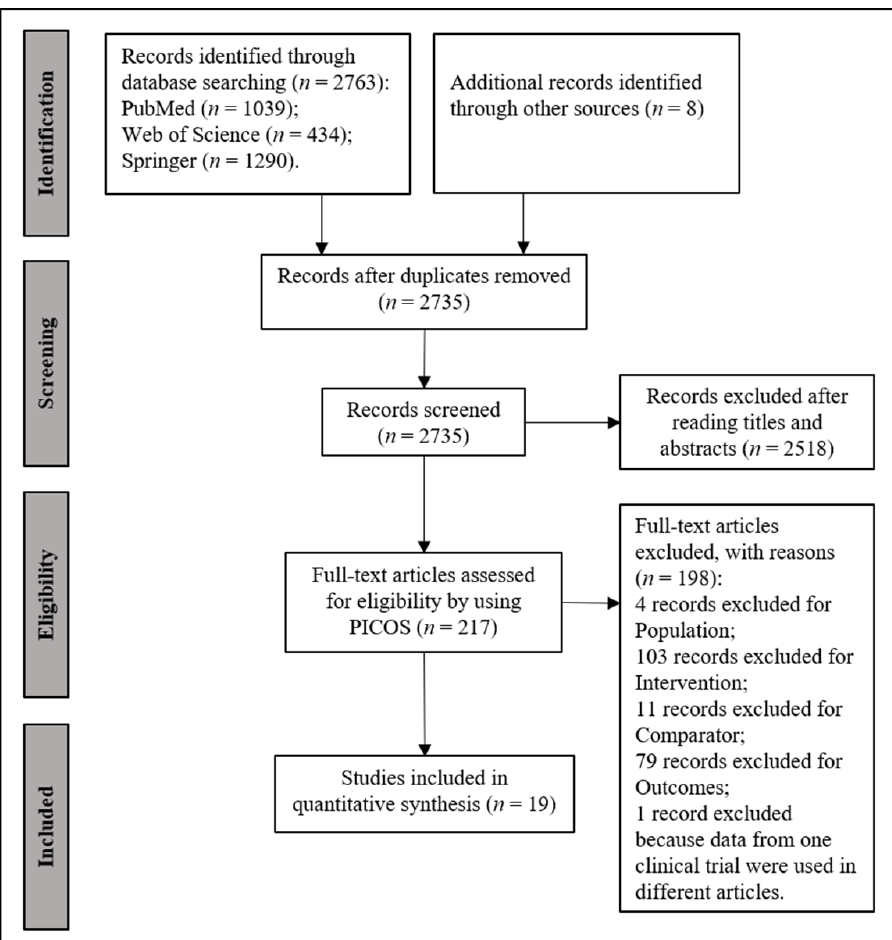
Figure 1. Flow chart of literature searching and screening.